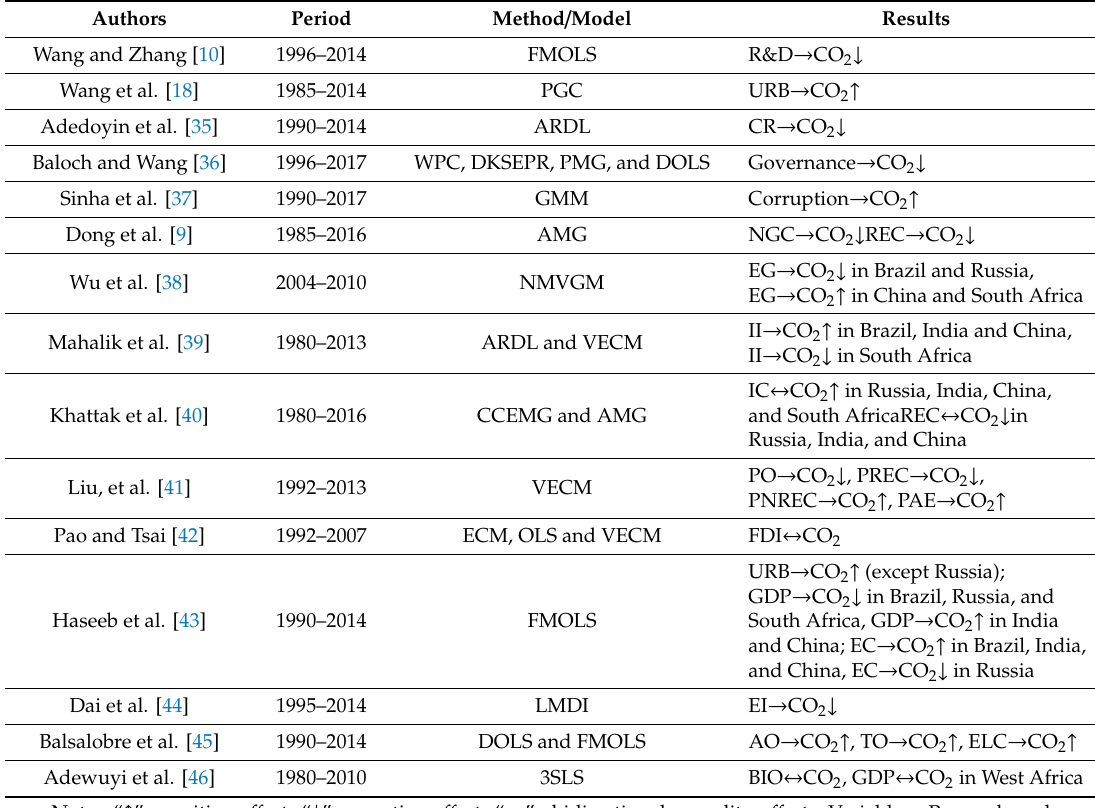
Table 2. Summary of the relevant literature of